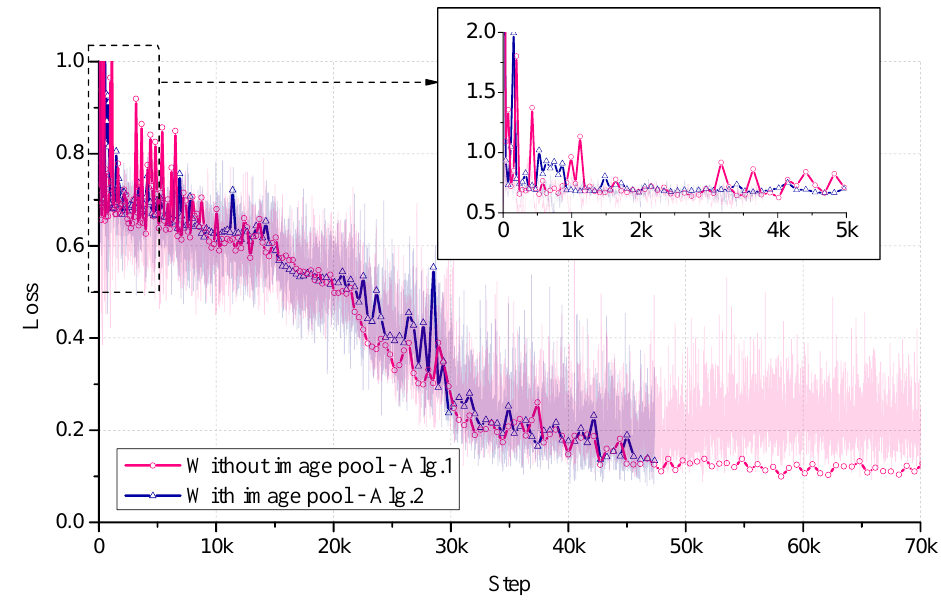
Figure 6. Loss curves of the two algorithms. Each symbol on the curve represents an